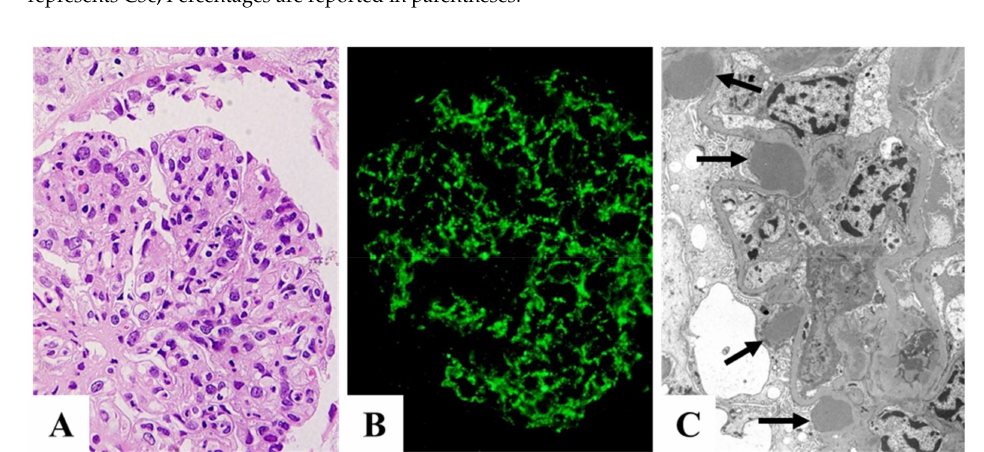
Figure 4. Characteristic pathology in the early phase of PSAGN. ( A ): Light microscopy (HE); endocap- illary proliferative glomerulonephritis. Original magnification: × 400. ( B ): C3 staining; fine granular deposits mainly on capillary wall, part of mesangium. Original magnification: × 400. ( C ): Electron microscopy; characteristic subepithelial dome-shaped humps (indicated by black arrows). PSAGN: post-streptococcal acute glomerulonephritis. Photographs are cited from a previously